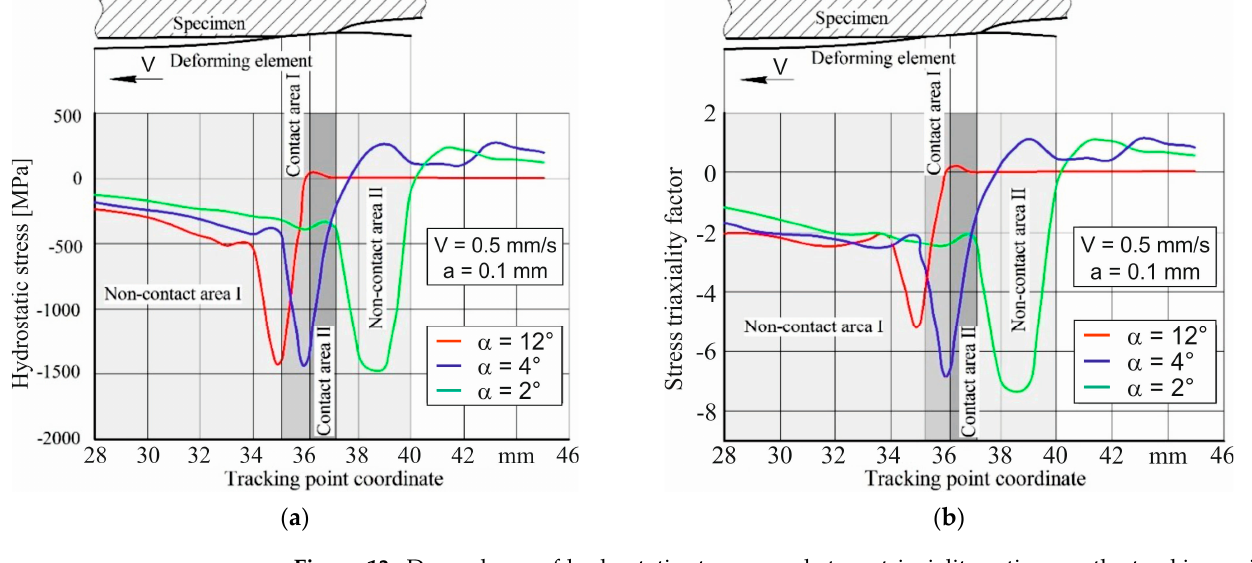
Figure 13. Dependence of hydrostatic stress σ and stress triaxiality ratio η on the tracking point coordinate. ( a ) hydrostatic stress, ( b ) stress triaxiality ratio.